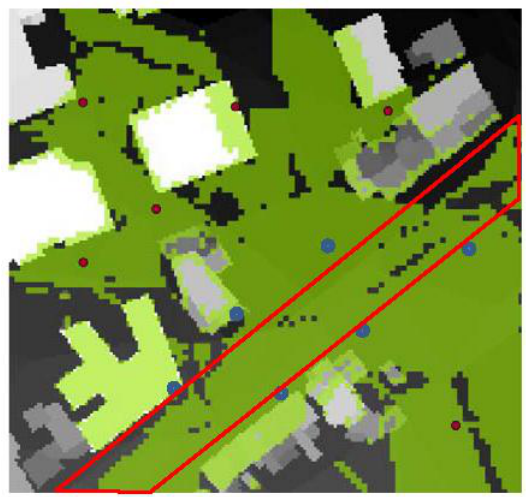
Figure 21. Simulation of the score dc on the weight map, followed by finding a new sensor position regarding the CI of desirability of coverage.